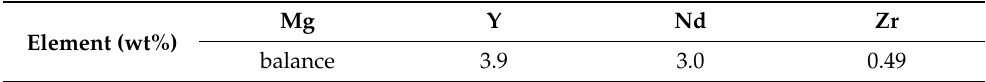
Table 1. Alloy composition as supplied by the manufacturer (NMD